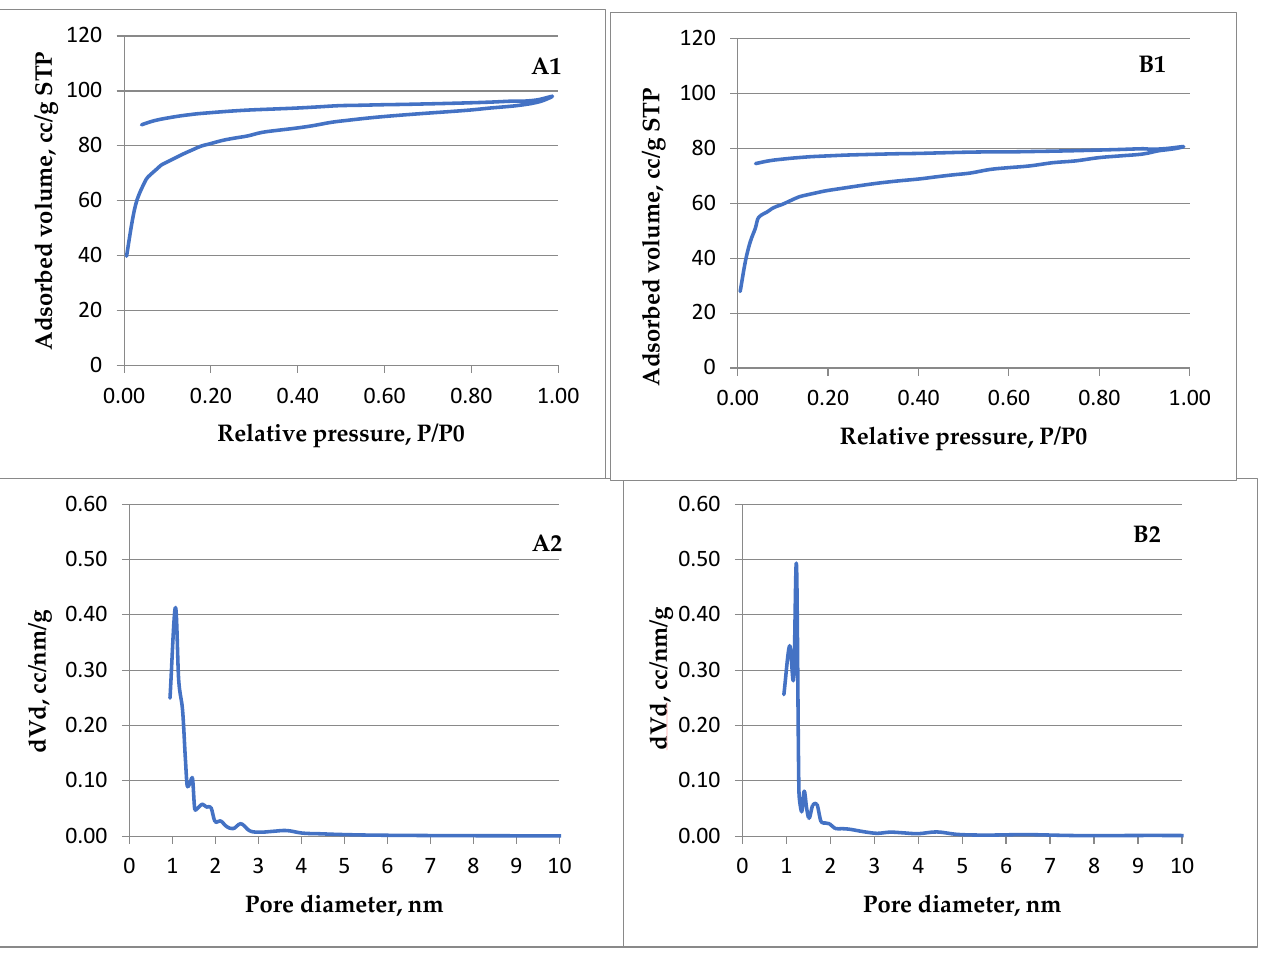
Figure 11. Nitrogen adsorption-desorption isotherms ( A1 , B1 ) and the corresponding pore size distribution ( A2 , B2 ) obtained for ACMP walnut samples ( A ) and peach kernels ( B ). In Table 5 a preliminary statistical analysis of the data sets is shown. Table 5. Statistical parameters for the porosimetric characteristics determined by SBET analysis.